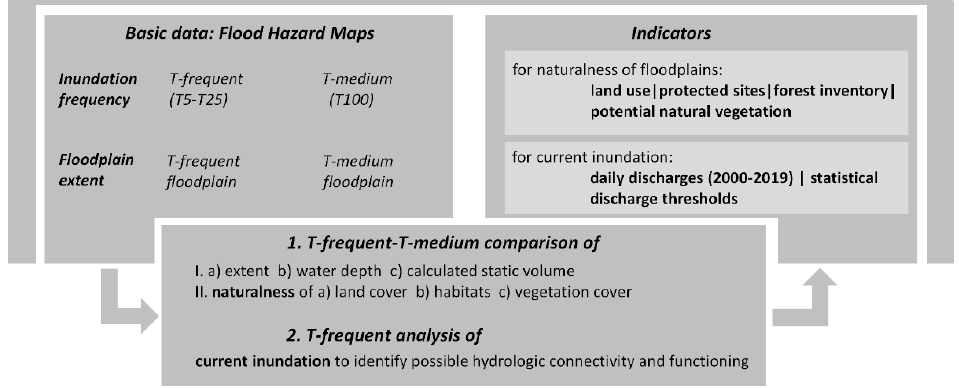
Figure 1. Operationalization of data used, developed indicators and research questions of this study.